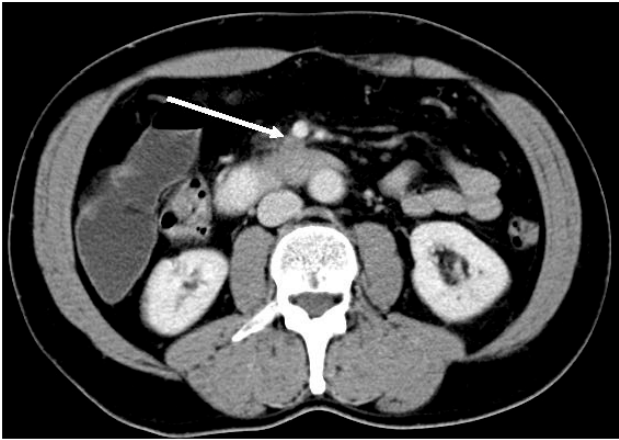
Figure 2. Computed tomography image of a tumor in the uncinate process with tumor contact to the superior mesenteric vein (smv) over a distance of about 2 cm (arrow: “borderline resectable”).